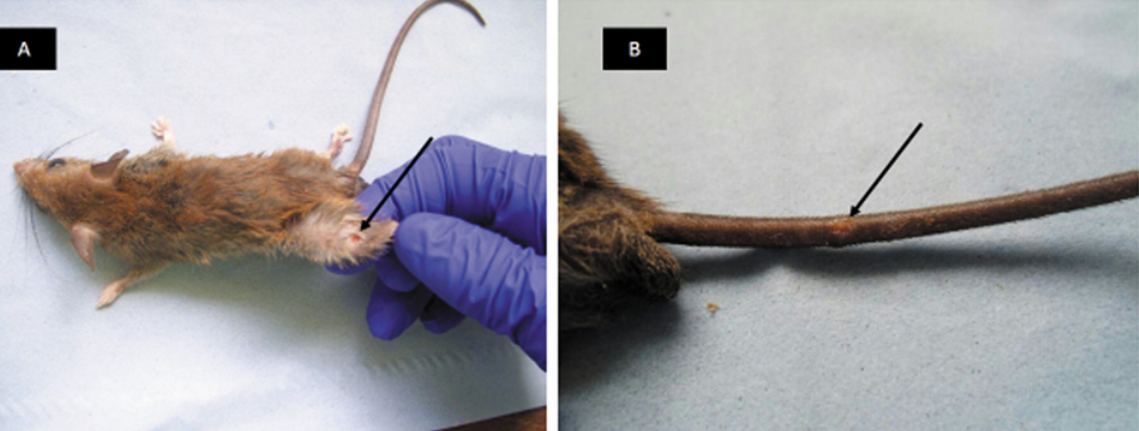
Figure 3. Two mice with lesions characteristic of BU. A) S6, had a lesion < 1cm on the left thigh. B) S11, with a lesion < 1cm on the tail, Lesion biopsy was positive for 16S rRNA , IS2404 and ER, which was confirmed as MU following sequencing.